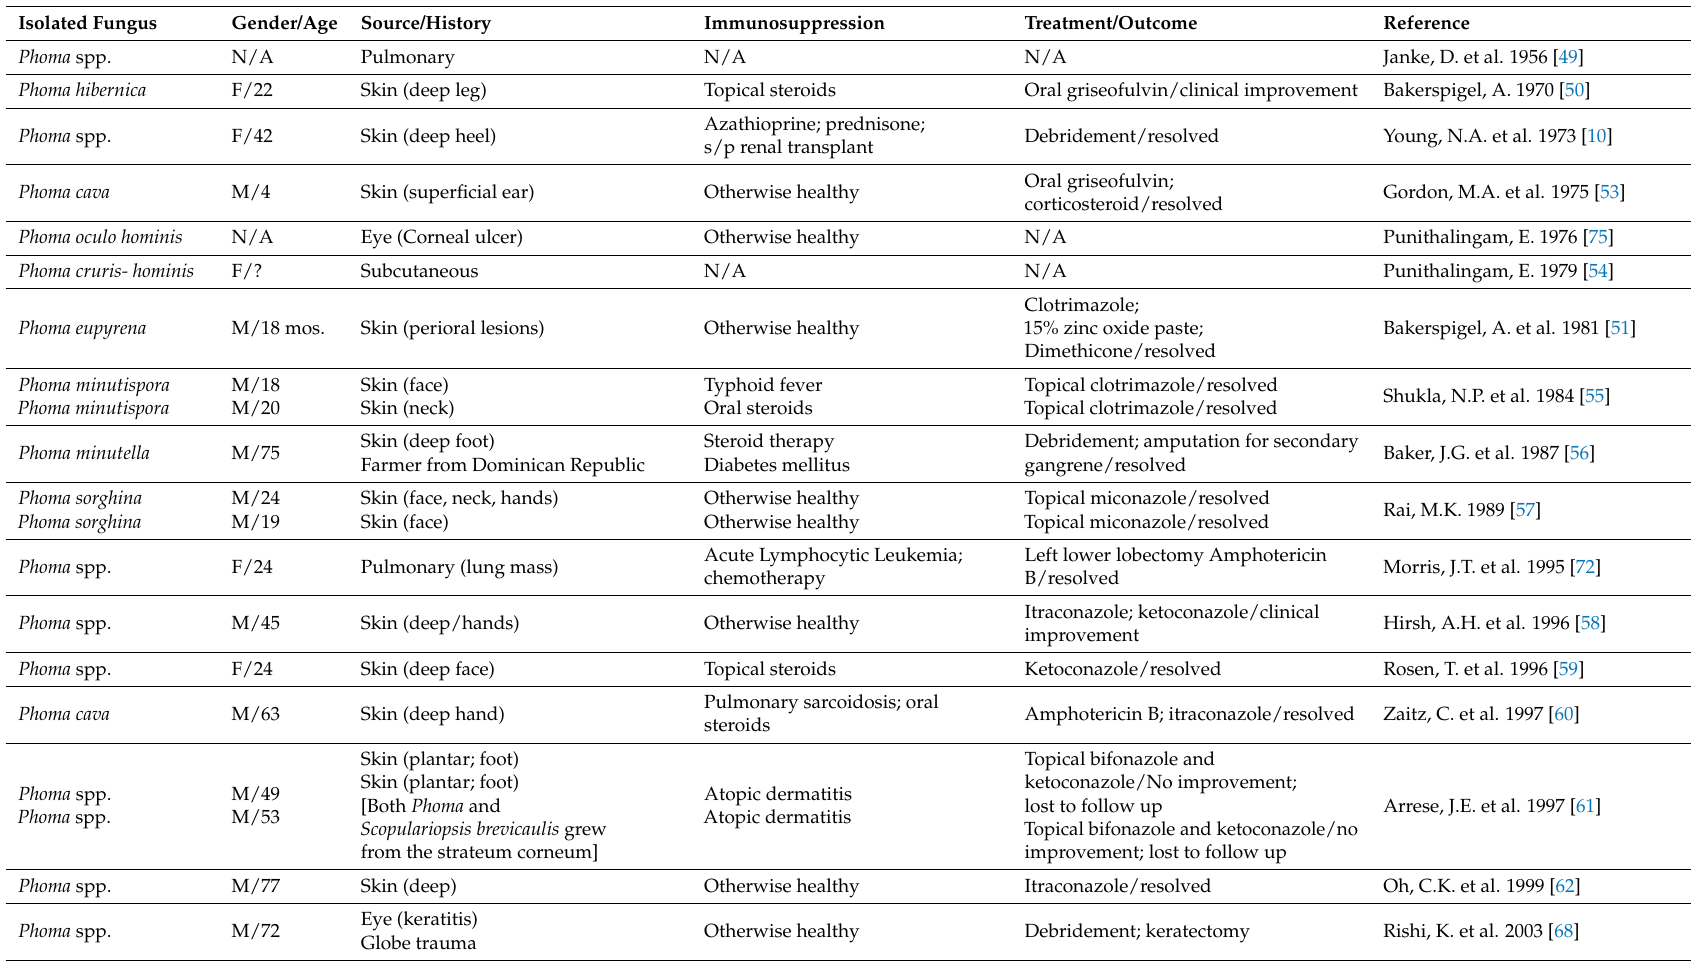
Table 1. Infections Caused by Phoma spp. in